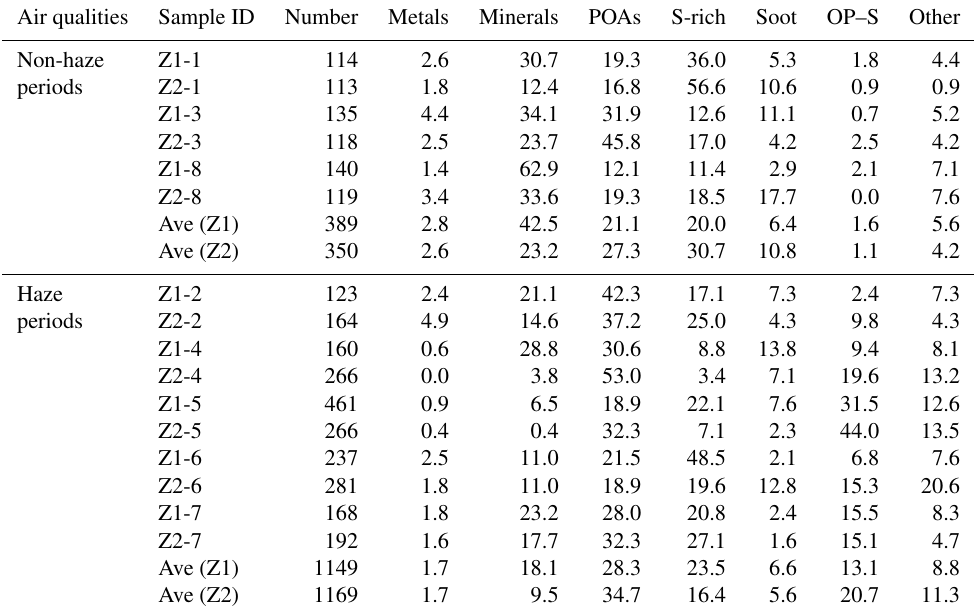
Figure 3. Relative number percentage of different particle types at ground level (Z1) and above the mixed-layer height (Z2). The number above each bar represents the total particle number analyzed in each sample. Table 3. Relative number percentage of individual